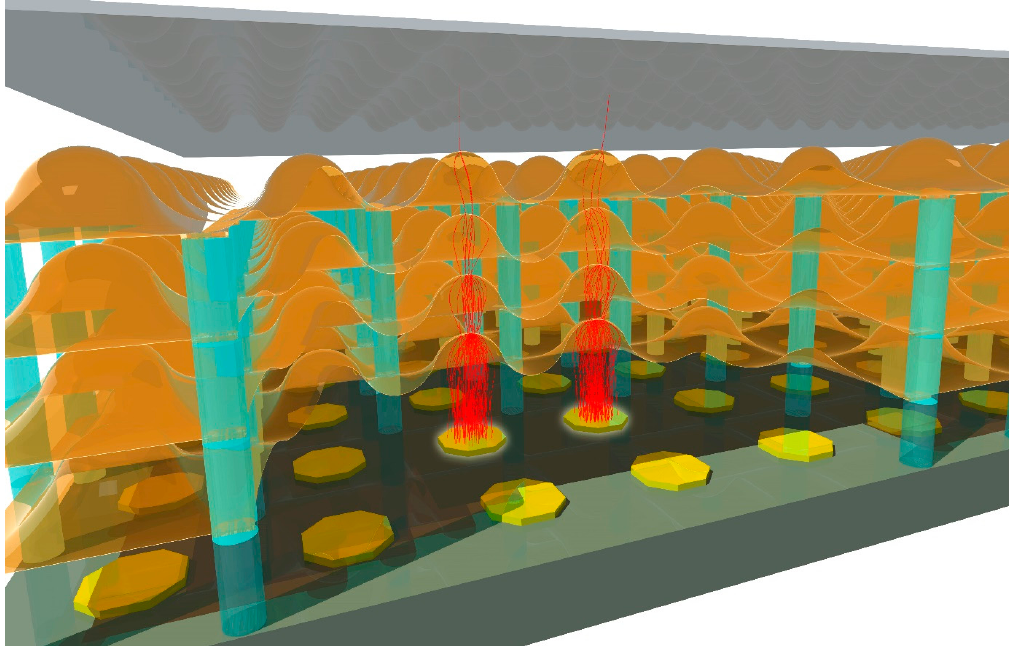
Figure 5. The essence of the MEMBrane project: a stack of transmission dynodes in vacuum placed on top of a CMOS pixel chip. By capping the assembly with a classical photocathode or an electron emission membrane, a photon detector “Tipsy” or charged particle tracking detector “Trixy” can be realized, respectively. The Tipsy detector, for example, is sensitive for individual soft photons (100–1000 eV), which are converted into photoelectrons in the photocathode and multiplied in the stack of transmission dynodes. The resulting electron avalanche is detected by the digital circuitry in the individual pixels of the CMOS chip.